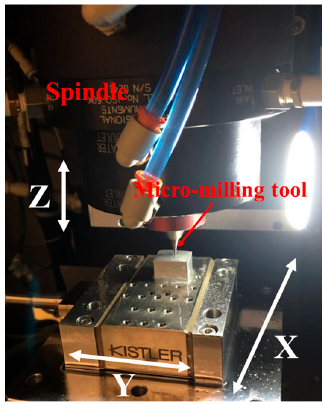
Figure 1. Schematic of the micro-milling machine and milling methodology. Table 1. Machining parameters.